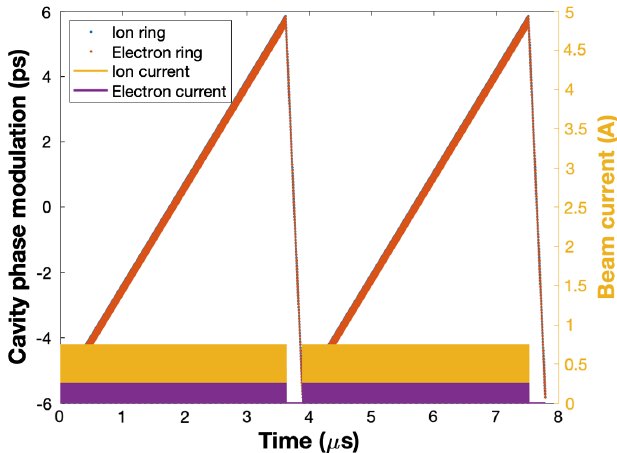
FIG. 17. Phase modulation with R=Q adjustments.